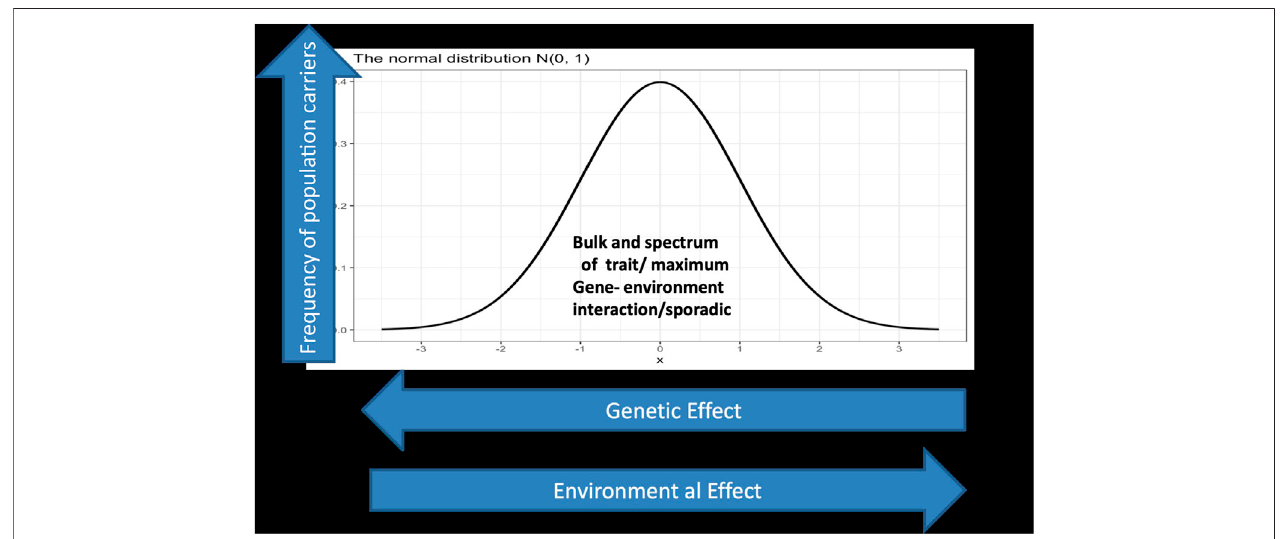
FIGURE 1 | displays a spectrum of gene environment interaction in a two dimensional landscape. The Y axis represents the phenotypic outcome of interactions whichisnormallydistributed,whilethe x axisdepictsthegenetic/environmentaleffectswhichisacontinuumstartingontheleftsidewithlargegeneticeffectasinthecase of monogenic and Mendelian inheritance and ends at the right side with low genetic effect but larger environmental effect, in the sense that genetic architecture matters less. Individuals carrying deleterious mutations in their genome with large effects fall under this category which represents in normal situations a tiny fraction of